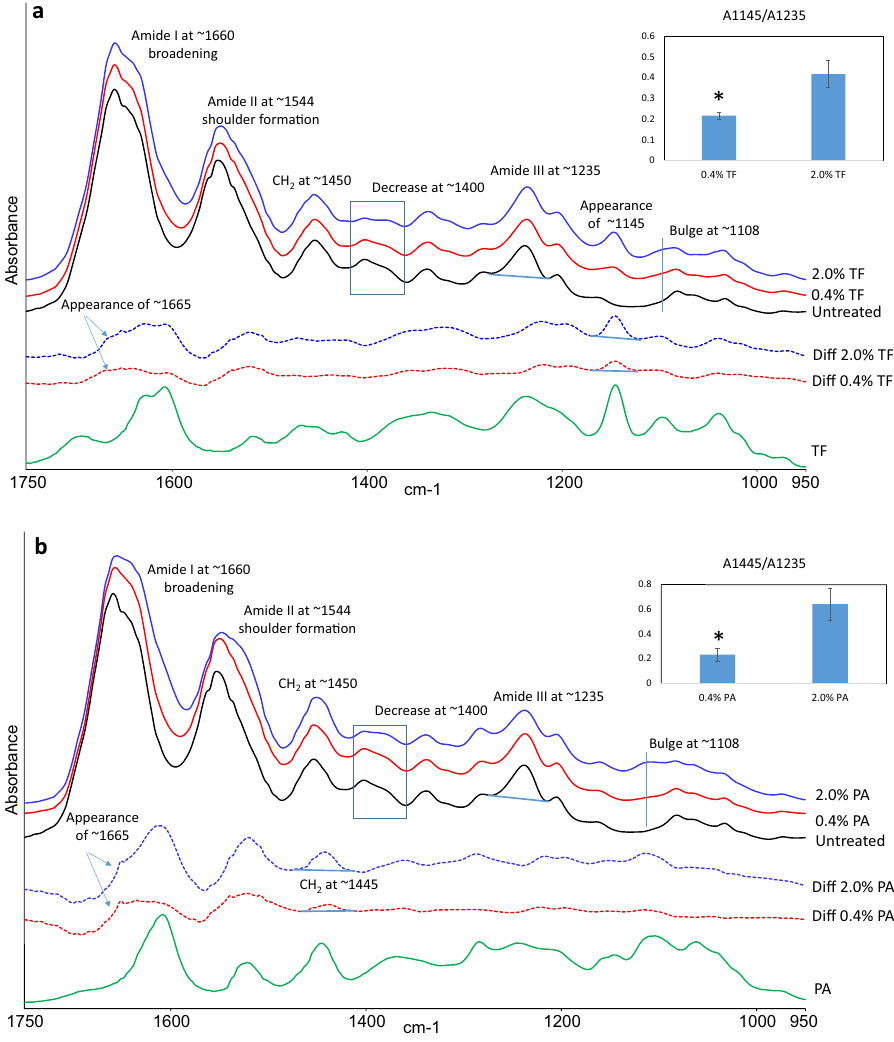
Figure 2. ( a ) Representative FTIR spectra of dentin collagen before (black line) and after the treatment of either 0.4% TF (red line) or 2.0% TF (blue line) for 30 s. Difference spectra of treated collagen films with the spectrum of untreated collagen subtracted (dashed lines) are shown in the middle and the spectrum of TF powder (green line) is shown in the bottom for comparison. Inset: the band ratios of A1145/A1235 for 0.4% TF and 2.0% TF treated collagen (* P < 0.001, n = 6). ( b ) Representative FTIR spectra of dentin collagen before (black line) and after the treatment of either 0.4% PA (red line) or 2.0% PA (blue line) for 30 s. Difference spectra of treated collagen films with the spectrum of untreated collagen subtracted (dashed lines) are shown in the middle and the spectrum of PA powder (green line) is shown in the bottom for comparison. Inset: the band ratios of A1445/ A1235 for 0.4% PA and 2.0% PA treated collagen (* P < 0.001, n =